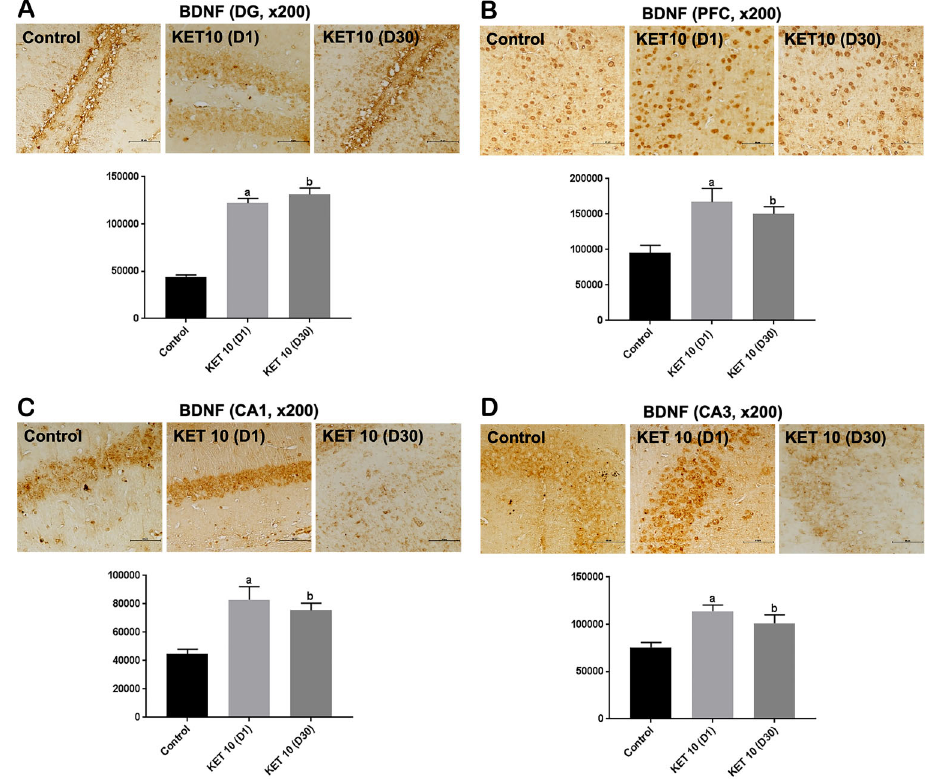
Figure 5. Single administrations of ketamine (KET, 10 mg/kg, ip ) signi fi cantly increased brain-derived neurotrophic factor (BDNF) expression in the A ) dentate gyrus (DG), B ) prefrontal cortex (PFC), C ) CA1, and D ) CA3 hippocampal sub fi elds compared with controls (3 animals per group). Representative photomicrographs, at (cid:1) 200 magni fi cation (50 m m), taken at D1 and D30 protocols. The graphs show the relative absorbance determined by the ImageJ software (NIH, USA). Data are reported as means ± SE. DG: a,b P o 0.05 vs Control; PFC: a,b P o 0.01 vs Control; CA1: a,b P o 0.05 vs Control; CA3: a,b P o 0.05 vs Control (one-way ANOVA and Tukey as the post hoc